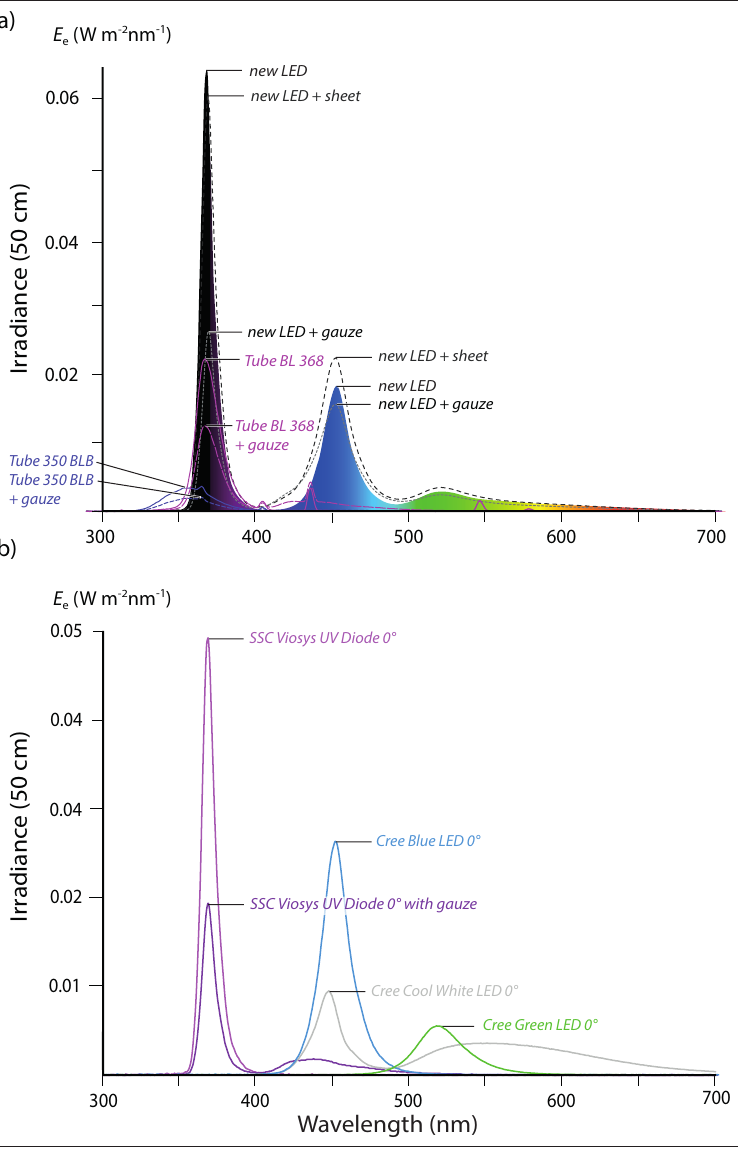
Figure 4. a. Irradiance from the four LED types used in the new LED lamp, measured at 50 cm distance and at 0° (see Fig. 3), and influence of Bioform ‘light tower’ gauze on the spectral composition of the UV LED. UV irradiance decreases significantly and a new blue peak appears at ca. 440 nm, probably due to optical bright- eners applied to the textile. b. Influence of Bioform ‘light tower’ gauze and a white sheet on the irradiance of the new LED lamp, of a 368 nm fluorescent actinic BL tube and a 350 nm fluorescent BLB tube. In all cases, a part of the UV radiation is absorbed and re-emitted by the textile as blue light, caused by optical brighteners. Distance between measuring device and lamp: 50 cm. The tower gauze was placed between the measuring device and the lamp. The sheet was placed 15 cm behind the lamp (increased irradiation due to